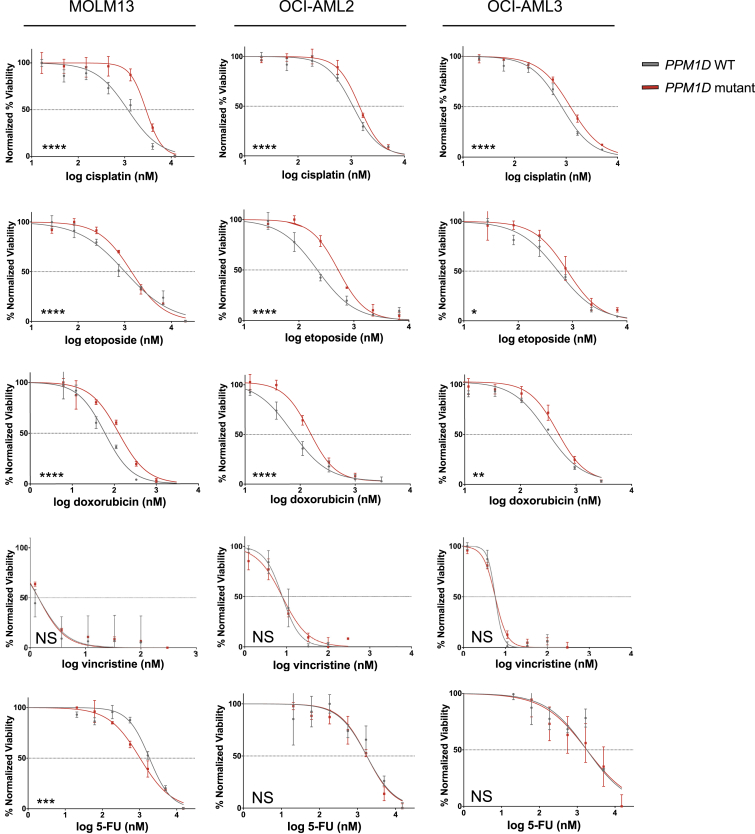
Screen for Chemoresistance in PPM1D MutantsVarious classes of chemotherapy agents were screened in the isogenic CRISPR-generated WT and PPM1D mutant cell lines (MOLM13, OCI-AML2, and OCI-AML3). The chemotherapy agents selected include key agents utilized in the treatment of primary tumors that t-AML/t-MDS patients in our cohort were previously exposed to. Dose response curves are shown, with red representing PPM1D mutants and gray representing WT. The data points represent mean ± SD of triplicates (n = 3).